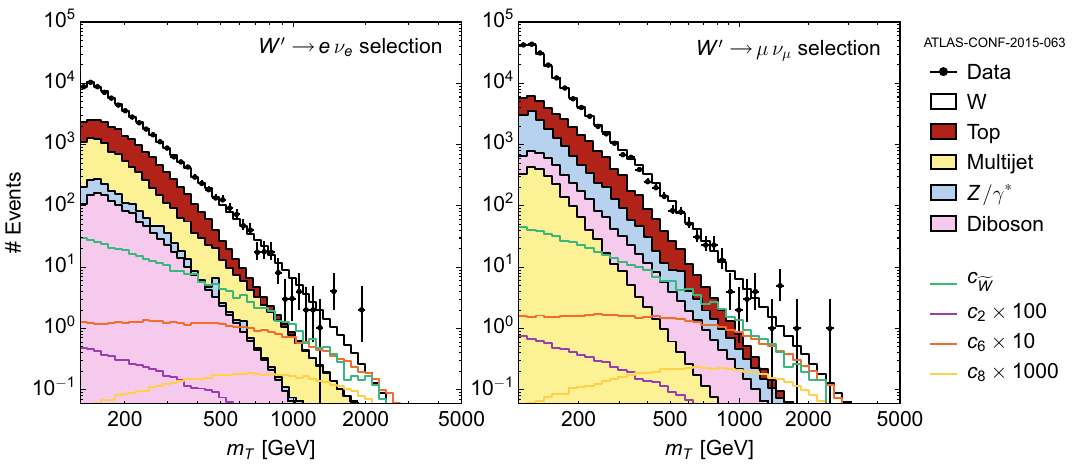
Fig. 3 Transverse mass m T distribution for a W ± ( W ± → (cid:17) ± ν (cid:17) ) pro- duction in the e + / E T final state ( left ) and μ + / E T final state ( right ), generated from A ˜ ( green ), A 2 ( purple ), A 6 ( orange ) and A 8 ( yellow ). W